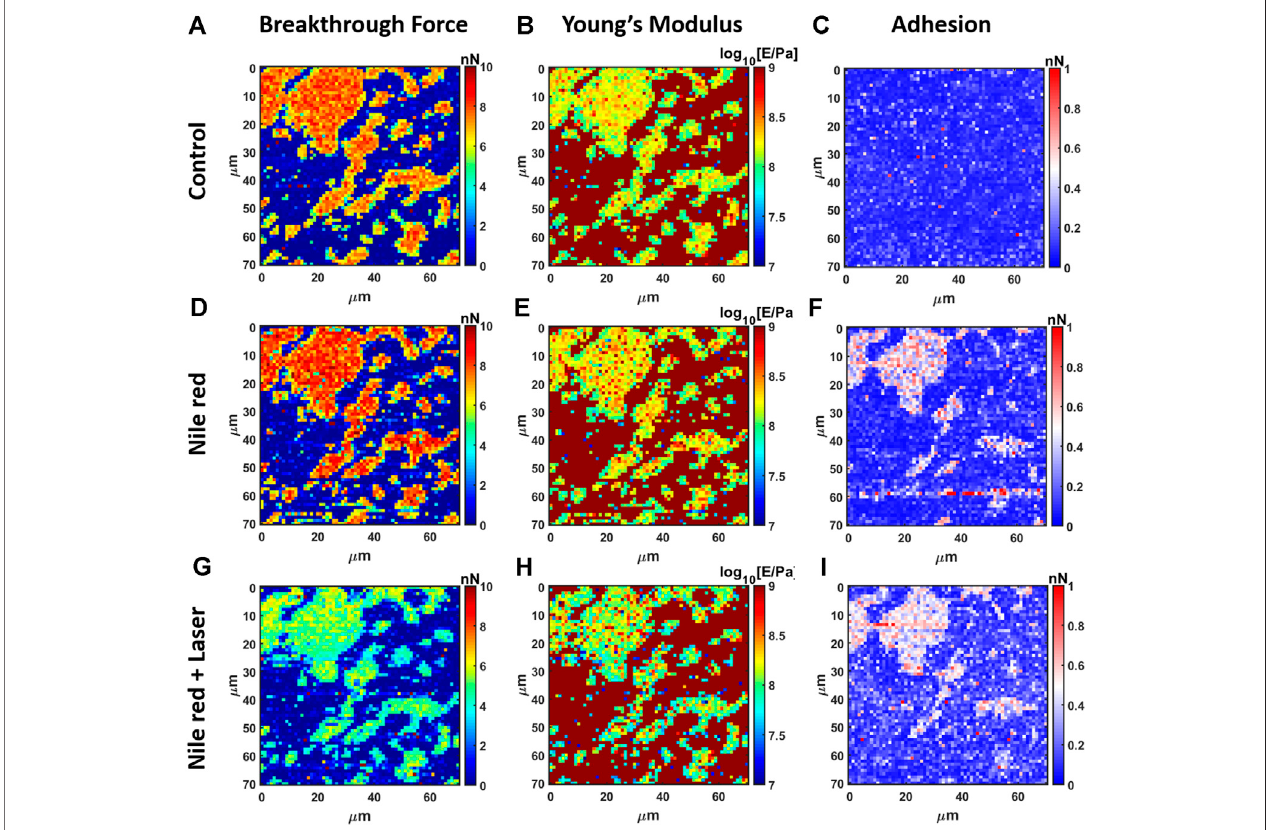
FIGURE6| ResultsofmechanicalanalysisofDOPCpartiallycoveringmicausingforcecurves. (A) Breakthroughforcemapof fi rstlayer, (B) Young ’ sModulusmap and (C) adhesion map on controlDOPC bilayer. With the same order of DOPC control (A – C) , DOPC after 30 min incubation with 2.5 ug/ml Nile red with DMSO at 2.5% (D – F) ), and after irradiating probe region with 35.4 mW/ μ m 2 green laser (G – I)